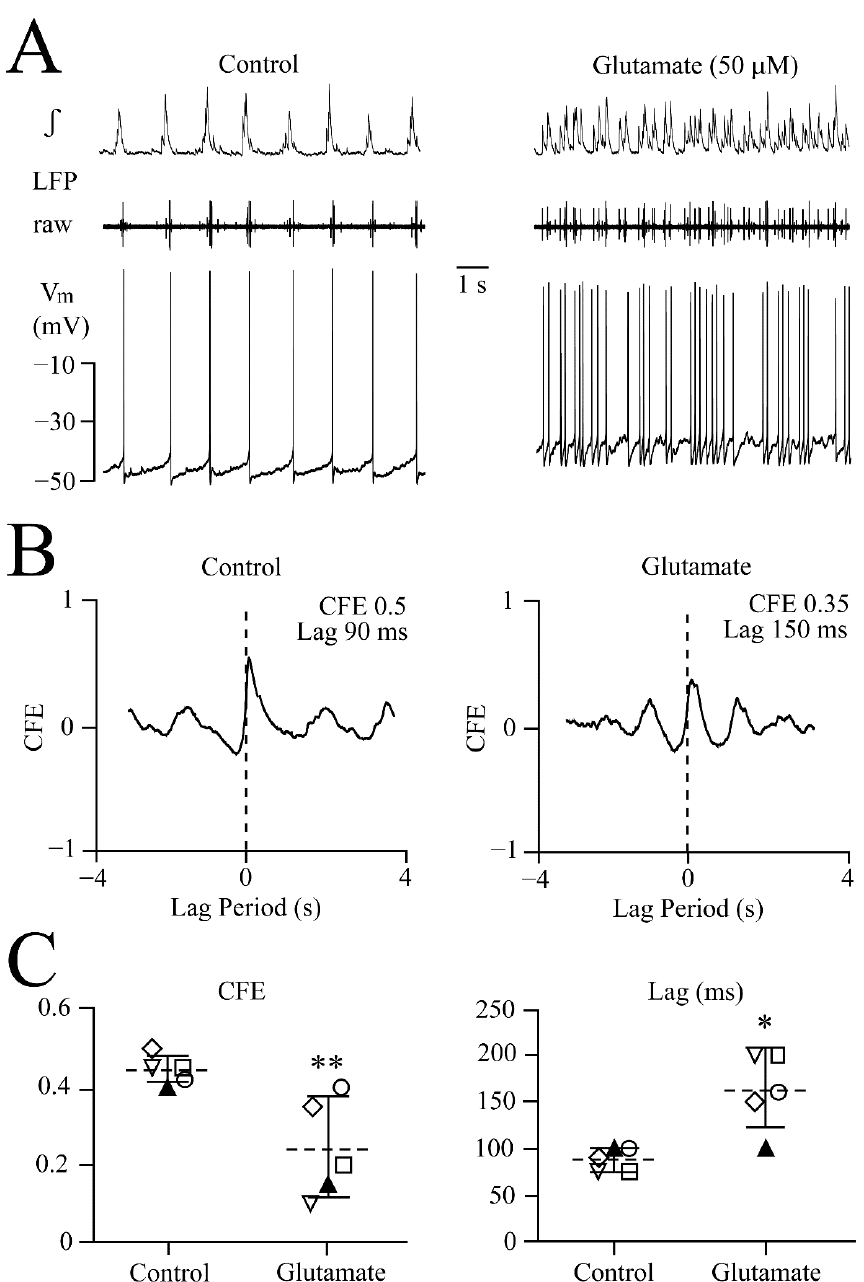
Figure 6. Cross-correlation of desynchronizing glutamate effects. ( A ) Left panel shows that a whole-cell-recorded LC neuron ‘spiked’ at the peak of membrane potential (V m ) ‘subthreshold oscillations’ (STOs) that were in phase with the simultaneously recorded LFP. Right panel shows that 50 µ M glutamate, 2 min after start of application, transformed the LFP pattern to irregular discharge accompanied by a neuronal depolarization of 7 mV and accelerated spiking with concomitant ~20% amplitude decrease that was reversible, as evident from the continuous recording from that neuron shown in Figure 10A. ( B ) Cross-correlogram between neuronal spike and LFP during control (left panel) and glutamate (right panel) shows a desynchronizing effect on the LC neuron network, indicated by a decreased correlation function estimate (CFE) value and increased lag time. CFE is the measure of the peak value on the Y axis and lag time indicates the shift of peak from 0 time on the X -axis. ( C ) Scatter plots from the neuron in ( A ) (filled symbol) and four other neurons reveal a difference in CFE values (left) and lag times (right) for control vs. glutamate and determined with two-tailed paired t -test. * p = 0.034, ** p =